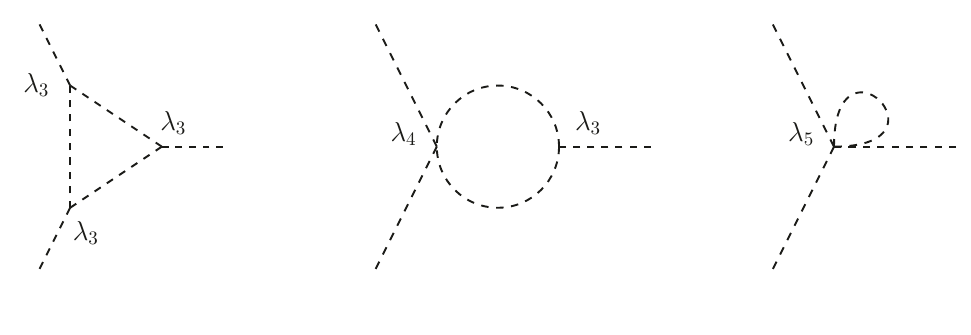
Figure 4 . Feynman Diagrams contributing to the HHH form factor at one